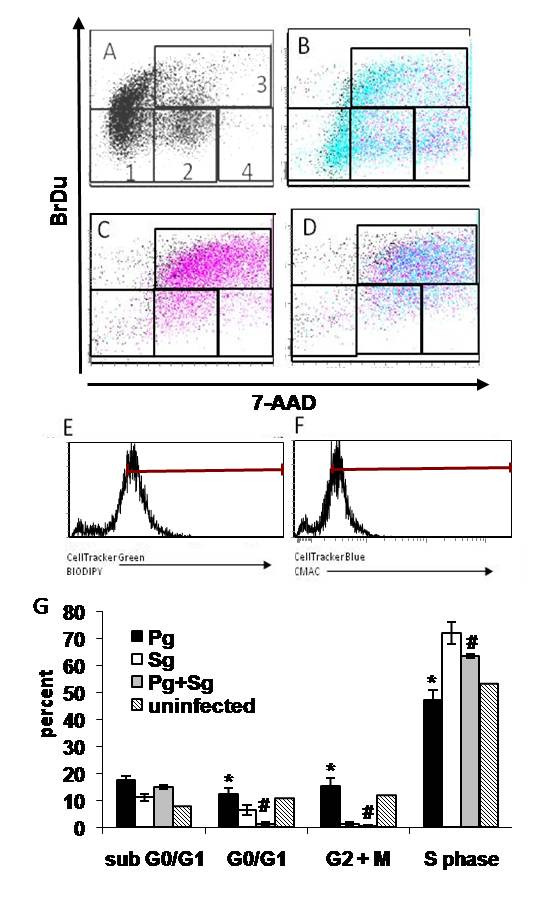
Infection with S. gordonii antagonizes the effect of P. gingivalis on the cell cycle. HIGK (uninfected in A) were simultaneously grown in the presence of BrdU and infected with P. gingivalis labeled with CellTracker Green BIODIPY shown in blue (B), CellTracker Blue CMAC labeled S. gordonii shown in pink (C), or a combination of P. gingivalis and S. gordonii for 4 h (D). HIGK cells were treated with antibiotic to kill extracellular bacteria and were cultured for an additional 20 h prior to harvesting for FACS analysis. The cell cycle positions and active DNA synthetic activities of cells were determined by analyzing the correlated expression of total DNA (7-AAD) and incorporated BrdU levels. Uninfected control HIGK were included for comparison of baseline cycling patterns. Data represent duplicate experiments. Region gate 1, HIGK were apoptotic (defined as sub G0/G1); region 2, G0/G1; region 3, S phase; region 4, G2+M. Panel E and F demonstrate the gated HIGK populations used throughout all the analyses for CellTracker Green labeled P. gingivalis and CellTracker Blue CMAC labeled S. gordonii, respectively. Panel G depicts quantitative analysis of HIGK cell cycling in response to mono- and mixed infections. Results are the mean of three experiments. Statistical analysis was conducted using an ANOVA with Bonferroni's Multiple Comparison Test. * Pg vs. Sg sub G0/G1, Pg vs. Sg G0/G1, Pg vs. Sg G2+M, Pg vs. Sg S phase, p value < 0.05. # Pg vs. Sg+Pg sub G0/G1, G0/G1, G2+M, S phase, p values < 0.001. Error bars represent the mean ± SD.